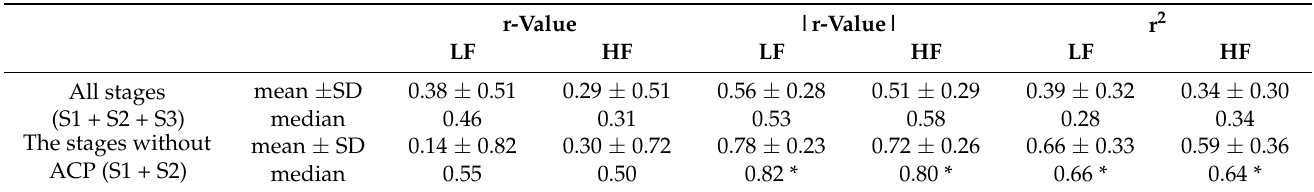
Table 8. The correlation between stroke volume variability (SVV) and heart rate variability (HRV) in all stage without aerobic capability plateau (ACP) stages of SVV bandwidth (low frequency